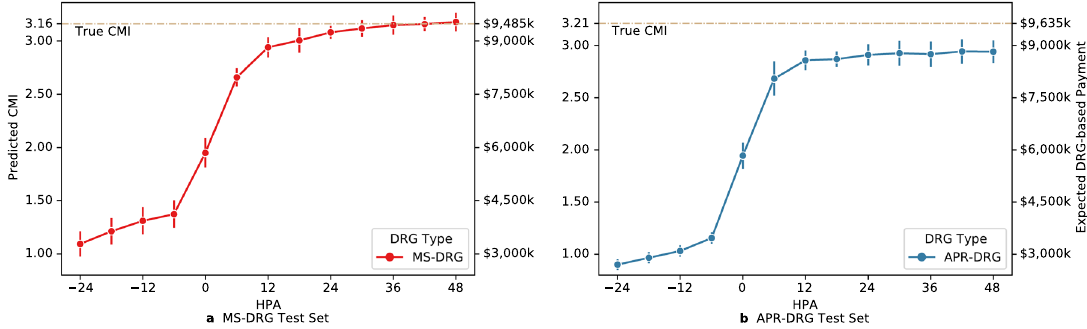
Fig. 3 Predicted CMIs and related DRG-based payment amounts for a cohort of 500 stays. Predicted CMIs (instead of CMI errors) at different HPA on randomly sampled 500 hospital stays from each DRG cohort set, averaged over fi ve models. Results on MS-DRG test cohort and APR-DRG test cohort are shown in sub fi gure a and b ,